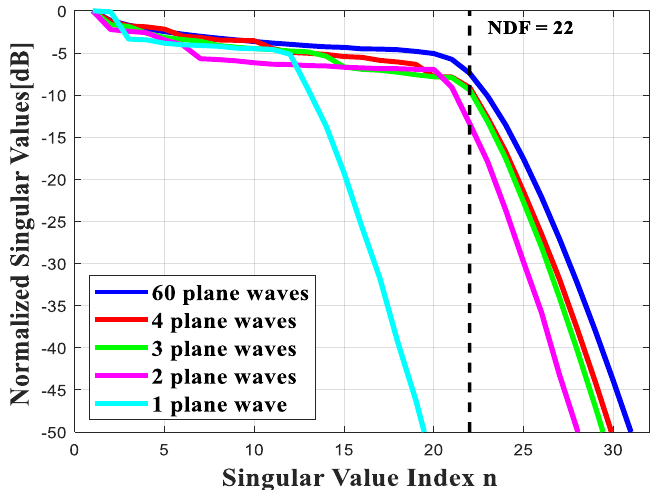
Figure 14. Comparison of the behavior of the normalized singular values of the linearized inverse scattering operator for different numbers of impinging plane waves for a single arc of the circumference ID.